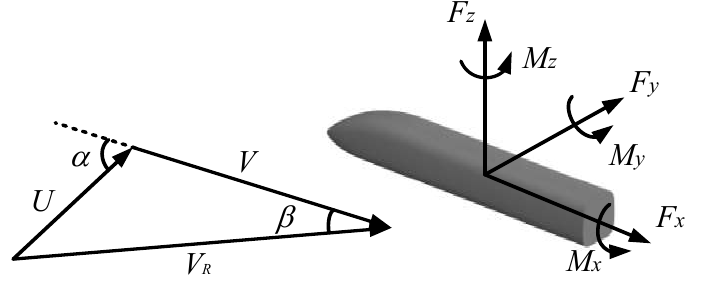
Figure 5. Diagram of speed vectors and aerodynamic forces on a moving train.